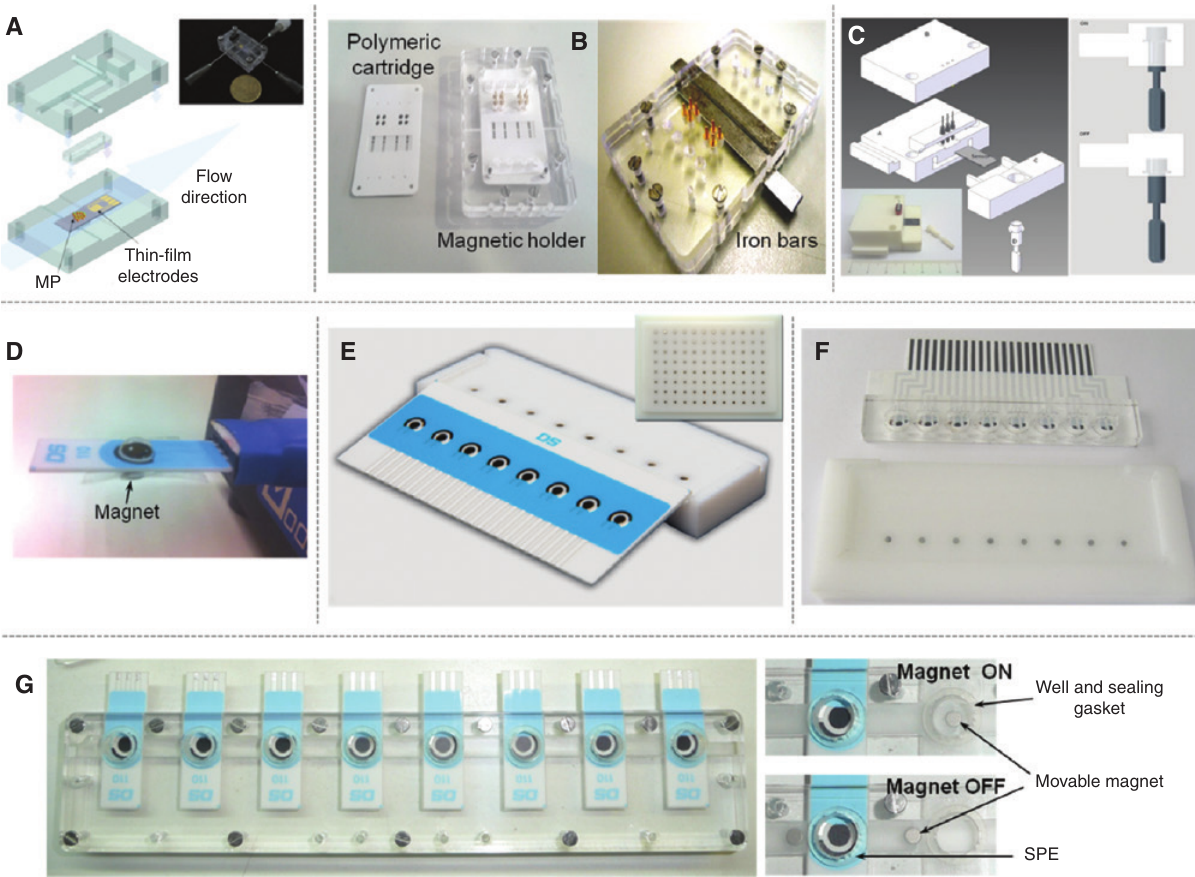
Figure 6: Examples of magnetic devices described previously for MP confinement onto a working electrode (additional information and bibliographic references are provided in the main